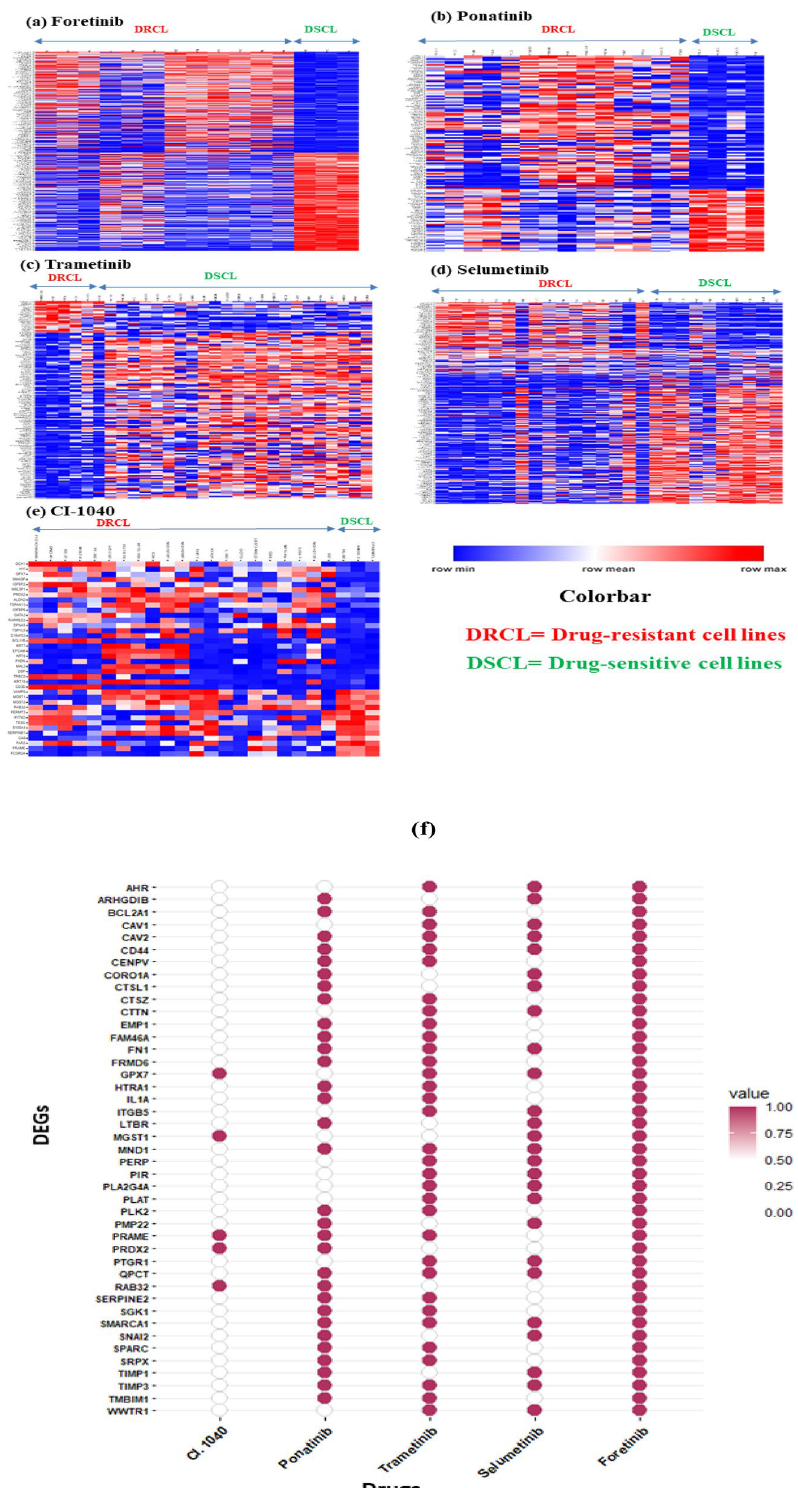
Figure 2. Differential gene expression analysis between drug-sensitive and -resistant cancer cell lines. ( a – e ) Heatmap of DEGs between drug-sensitive and -resistant cancer cell lines. Expression pattern of DEGs in cancer cell lines for each drug is shown. Red color: up-regulated genes, blue color: down-regulated genes. ( f ) Genes that are differentially expressed (reddish-brown bubble) between drug-sensitive and -resistant cancer cells in the case of multiple